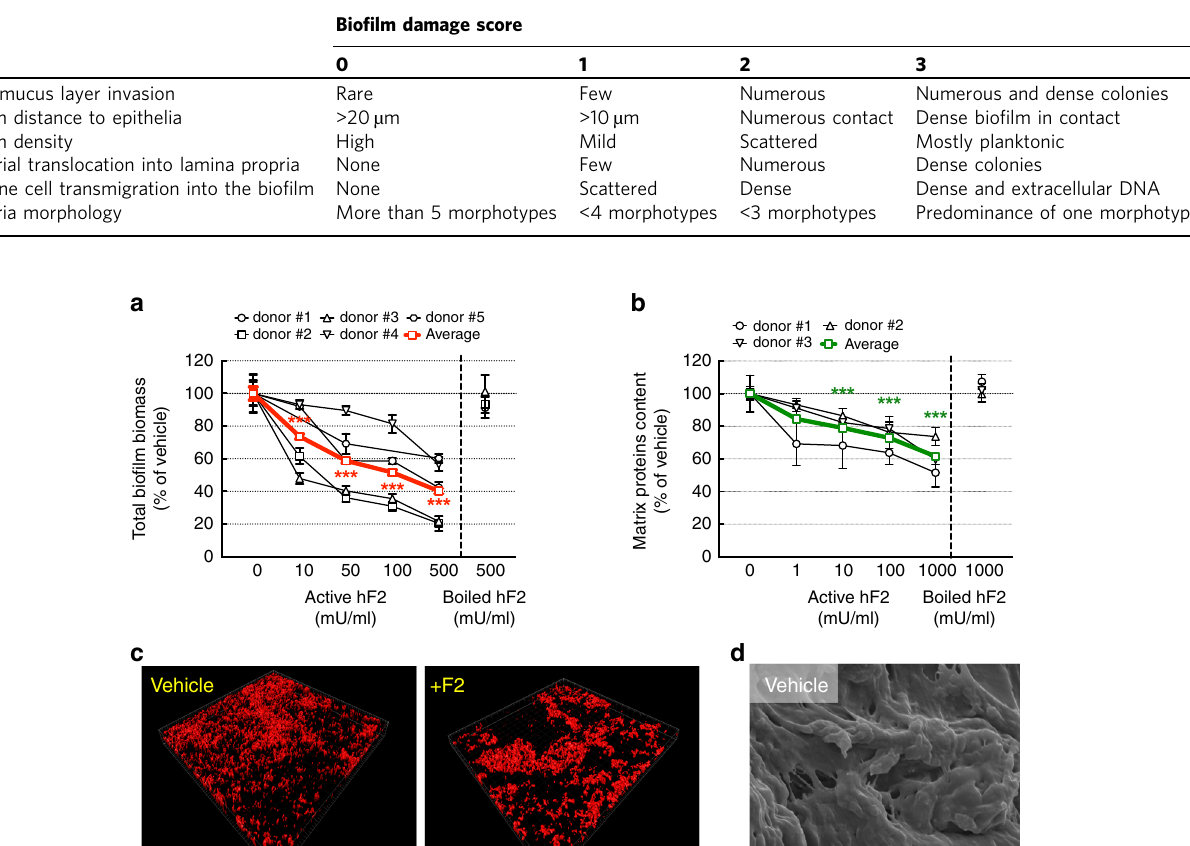
Table 1 Bio fi lm damage score of the distal colon